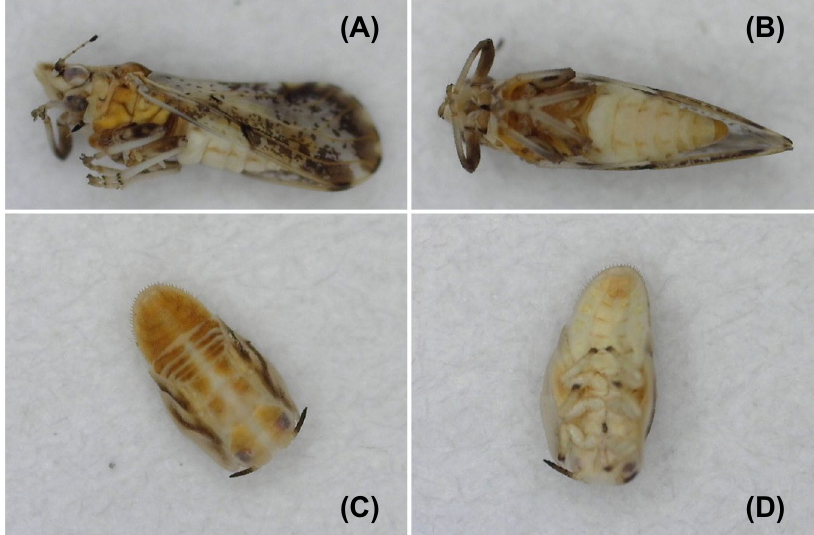
Figure 1. The lateral ( A ) and ventral ( B ) views of adult Asian citrus psyllid ( Diaphorinacitri Kuwayama) and corresponding dorsal ( C ) and ventral ( D ) views of D. citri nymphs sampled from different locations (Table 1) in southern Republic of